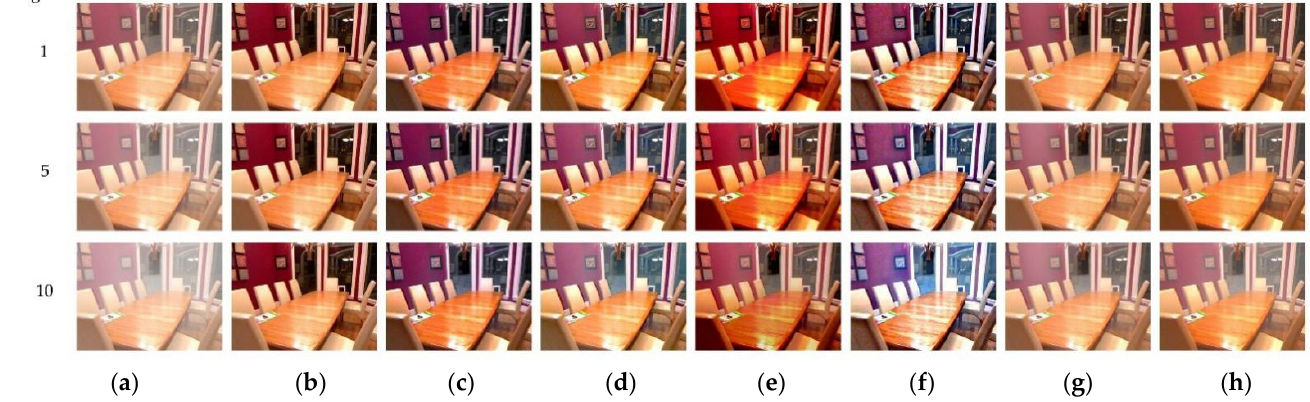
Figure 5. Dehazing effects of various methods on indoor composite images under different fog concentrations. ( a ) Input images, ( b ) fog-free image, ( c ) Dhara method, ( d ) Berman method, ( e ) Choi method, ( f ) Cho method, ( g ) Cai method, and ( h ) the proposed GIC method.